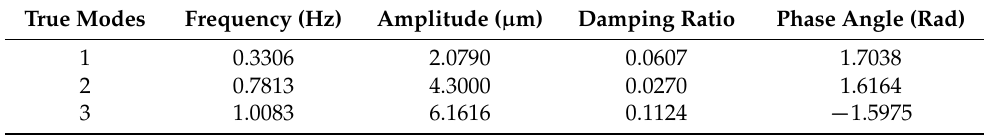
Table 8. Modal parameters matching results of signal B.